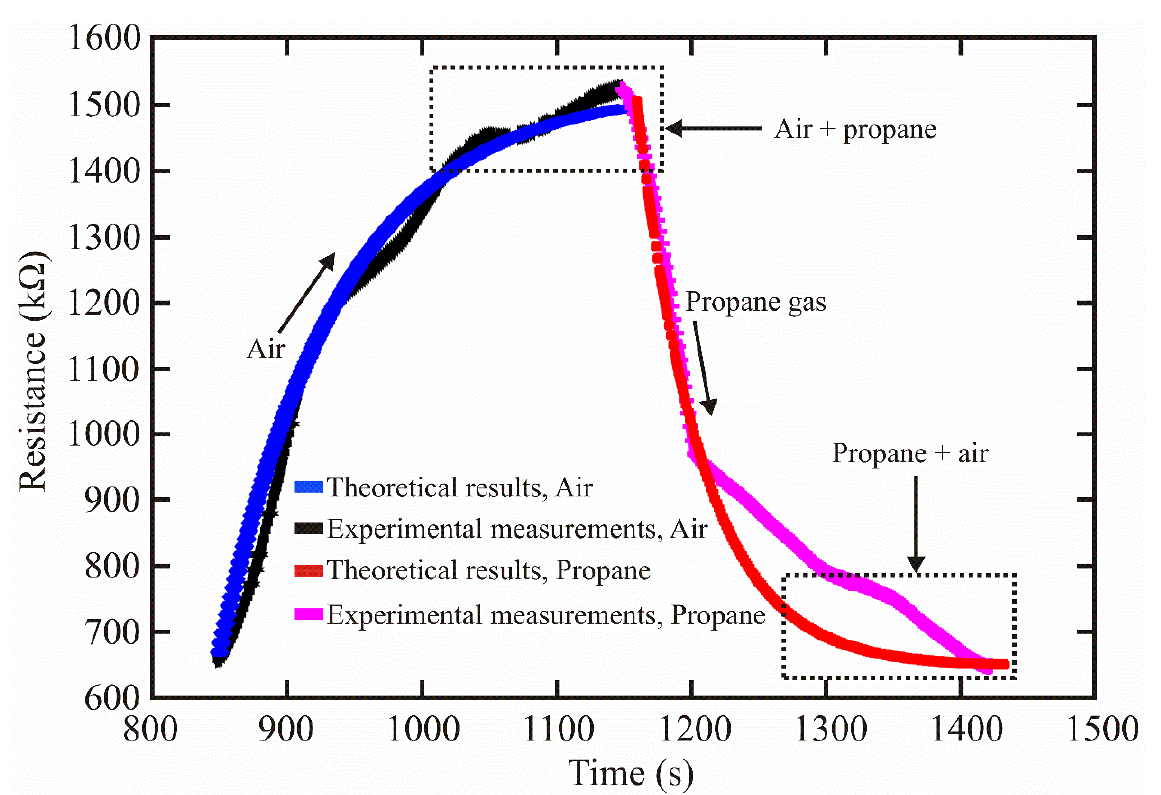
Figure 3. Theoretical and experimental sensing results of the ZnAl 2 O 4 . From Figure 3, the theoretical result was close to the experimental measurements when the sensor detected air and propane gas. The minor variations can be attributed to experimental errors, system noise, or contamination in the measurement